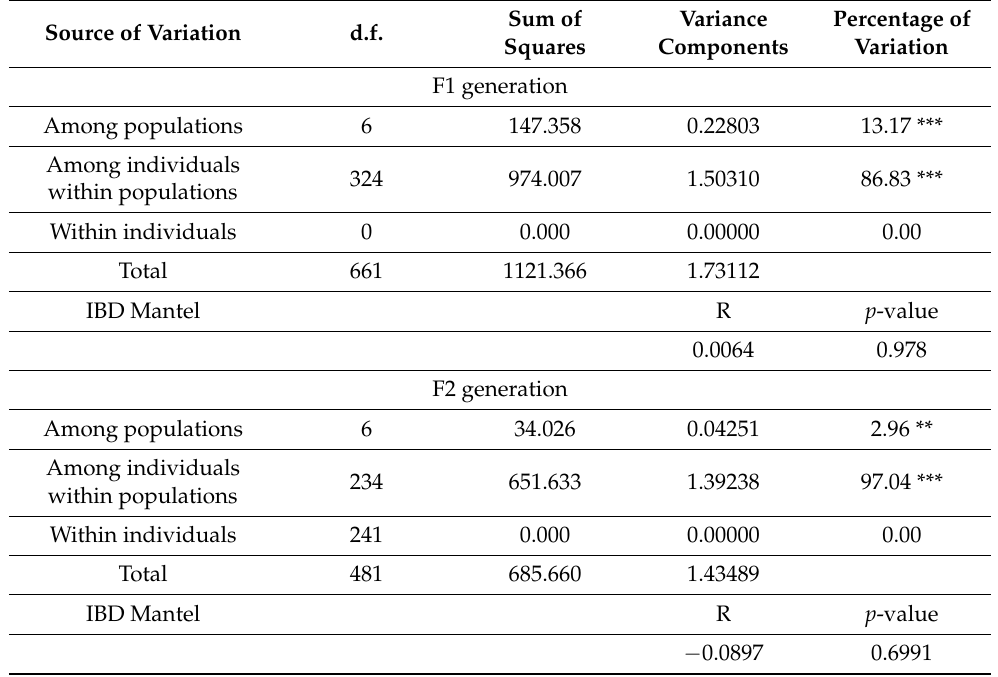
Sum of Variance Percentage of Squares Components Variation F1 generation 324 974.007 1.50310